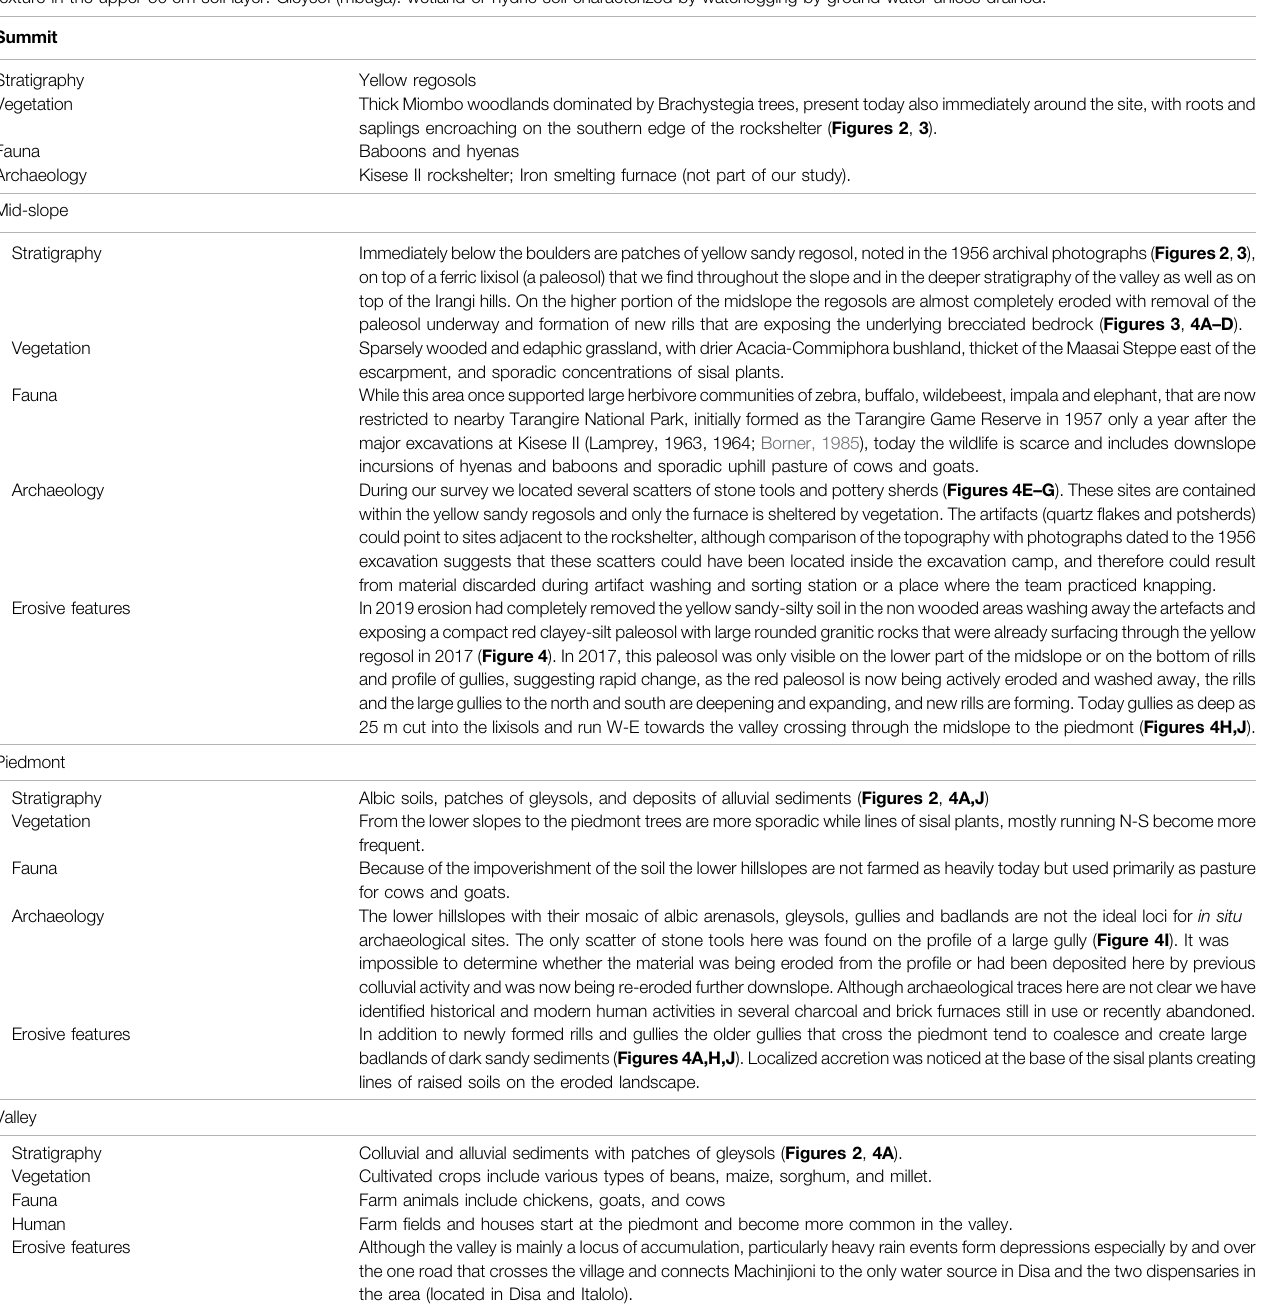
TABLE 1 | Commentary to the geoarchaeological catena ( Figure 2 ) listing the recorded categories for each section of the surveyed area that was divided into 4 sections dependingonitspositiononthelandscape.Weidenti fi edsoilsusinggeologicalmapsandpastgeologicalsurveysoftheregion.Characteristicsforeachsoilweidenti fi ed are as follows: Regosols: weakly developed soil found on unconsolidated materials. Luvisols: a well developed soil with an eluviated argic subsoil. These soils are prone to erosionwhenfoundonslopesandrequireterracingorotherkindsofhumaninterventiontoretainstability.Albicarenosols:bleachedsandysoilhavingsandoranothercoarse texture in the upper 50 cm soil layer. Gleysol (mbuga): wetland or hydric soil characterized by waterlogging by ground water unless